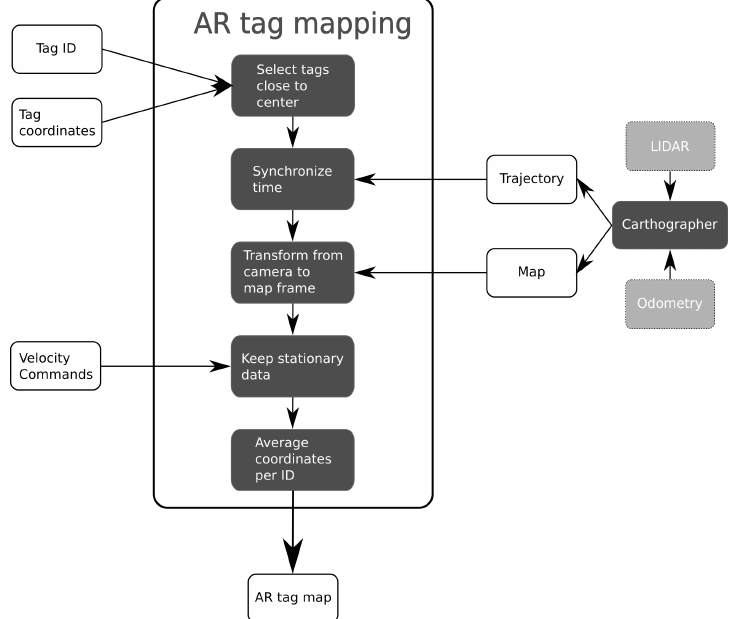
Figure 3. Calibration postprocessing